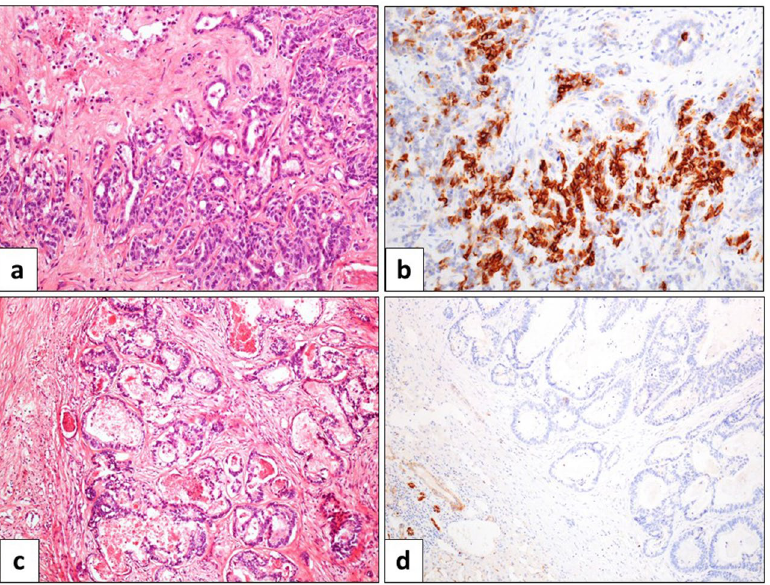
Figure 2. Pathological features of the two iCCA subtypes. ( a) Haematoxylin–Eosin stain) iCCAs of the small- duct subtype show small and regular ducts and tubules, lined by a cuboidal epithelium with generally few atypia, and surrounded by a dense and desmoplastic stroma. ( b ) Immunohistochemistry for CD56 is generally positive, as suggested by the most recent guidelines. ( c) Haematoxylin–Eosin stain) iCCAs of the large-duct subtype show large and branching ducts, lined by variable cells, from cuboidal to columnar, with variable amount of mucinous component. ( d ) Immunohistochemistry for CD56 is typically negative. Magnification